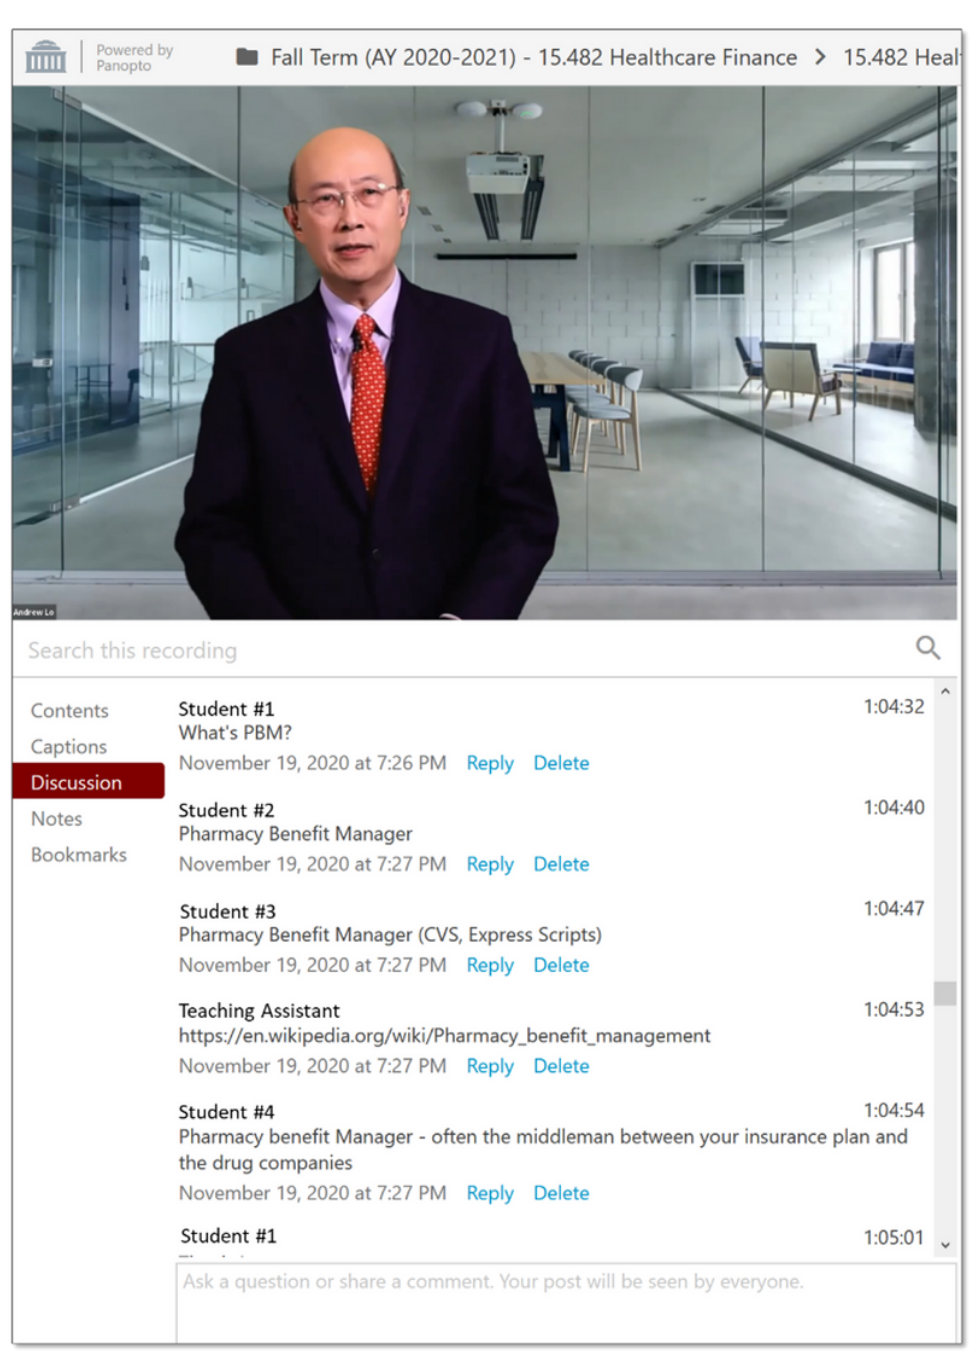
Figure 6. An illustration of the power of the chat window in Zoom during one of Andrew’s lectures in the online version of Healthcare Finance. Andrew referenced ‘pharmacy benefit manager’ by its acronym, ‘PBM,’ without defining it and within 22 seconds, a student’s query in the chat window was answered by three classmates and the